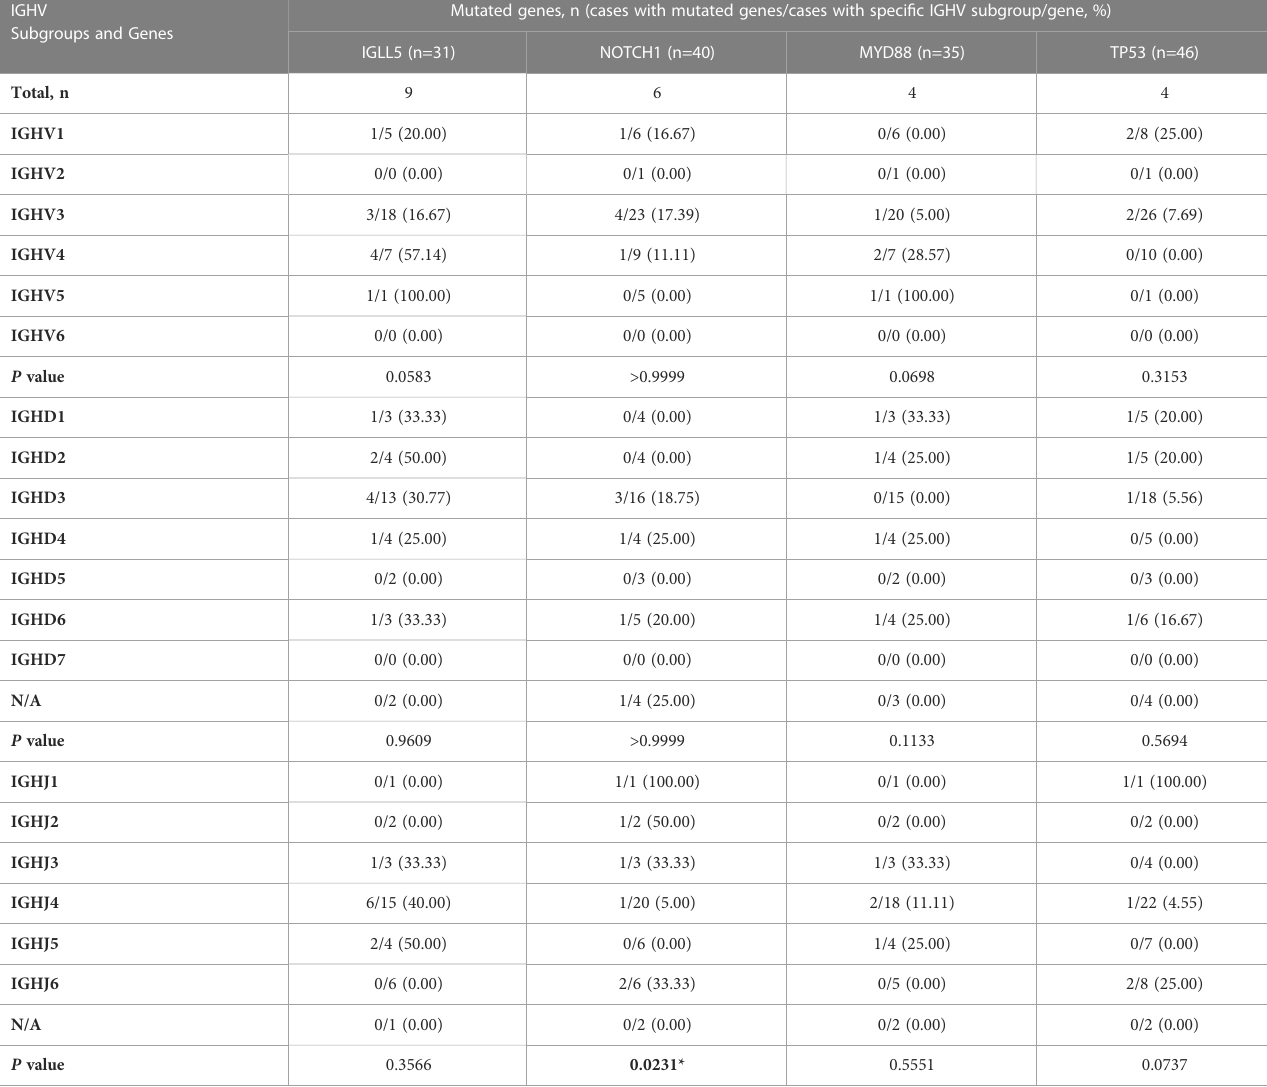
Mutated genes, n (cases with mutated genes/cases with speci fi c IGHV subgroup/gene,